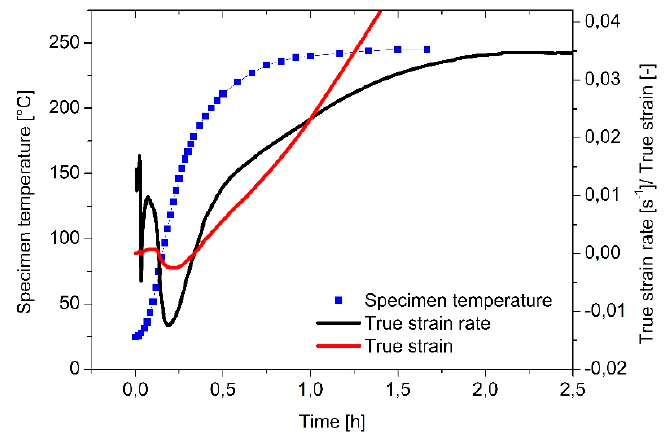
Figure 10. Comparison of the curves of true strain, true strain rate, and specimen temperature in the early primary creep stage.